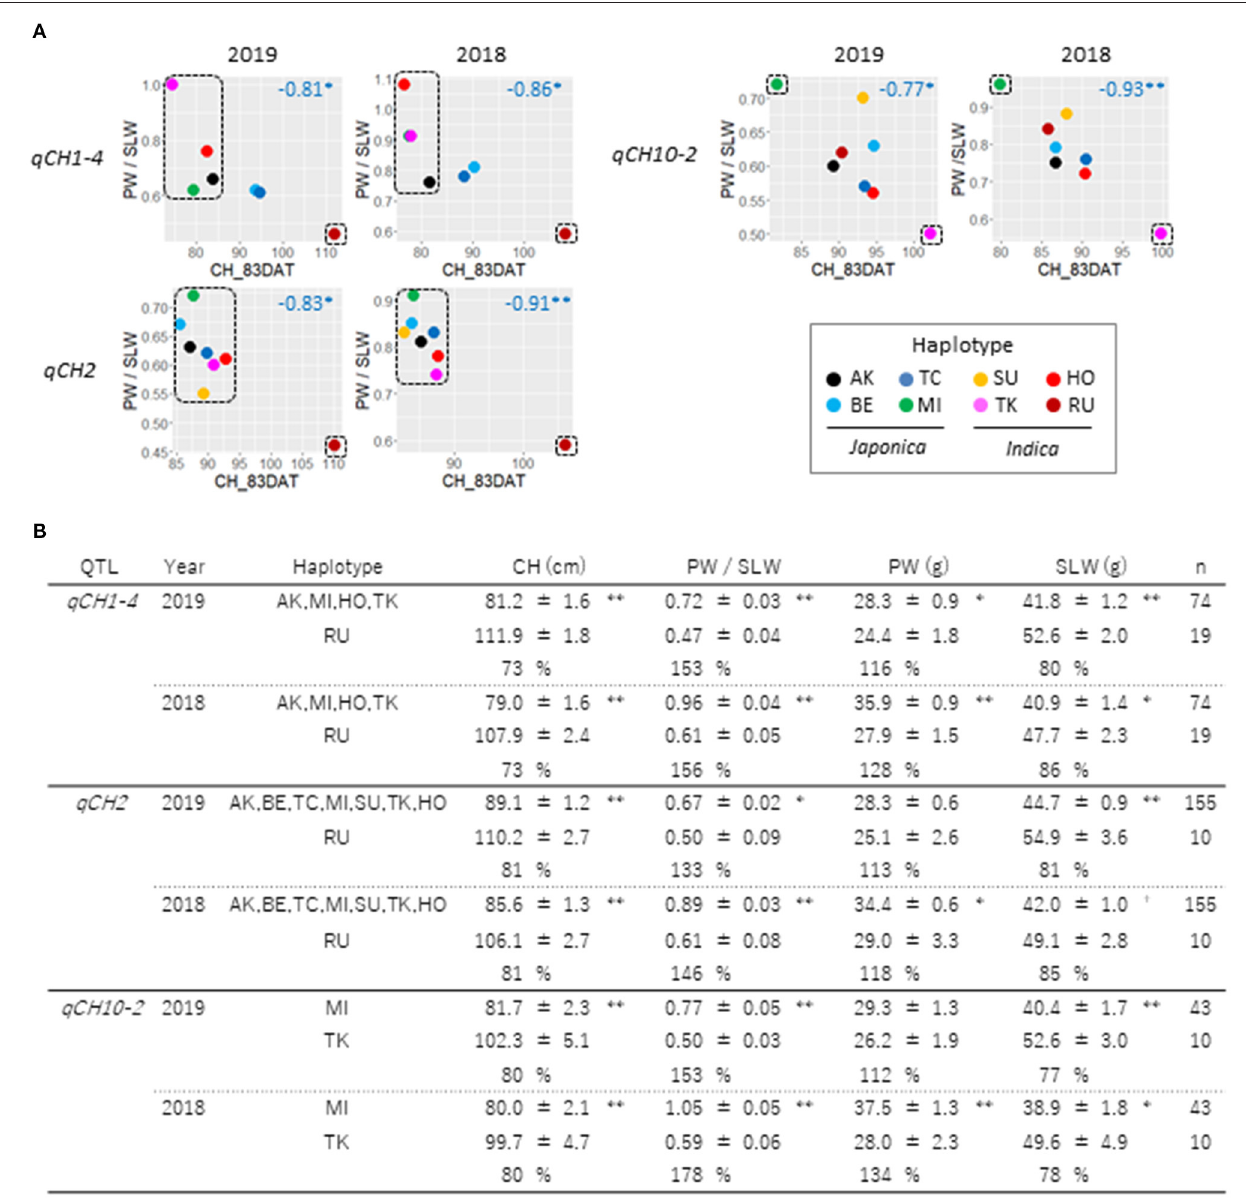
FIGURE 5 | Relationships between CH and ratio of PW to SLW at qCH QTLs. (A) Haplotype effects on CH at 83DAT and ratio of PW to SLW in 2019 (left) and 2018 (right) at qCH1-4 , qCH2 and qCH10-2 were plotted. Numbers in blue indicate Pearson’s r . Asterisks indicate significant correlations (Pairwise two-sided, ** P < 0.01, * P < 0.05). (B) Comparison of haplotype effects on CH, PW/SLW, PW and SLW at qCH1-4 , qCH2 and qCH10-2 were shown. Data on haplotypes enclosed by dotted lines in (A) at the three QTLs were examined. Mean ± standard error of phenotypes and ratio of phenotype data in top haplotype class to that in bottom haplotype class at each QTL were shown (student t -test: ** P < 0.01, * P < 0.05, + P <